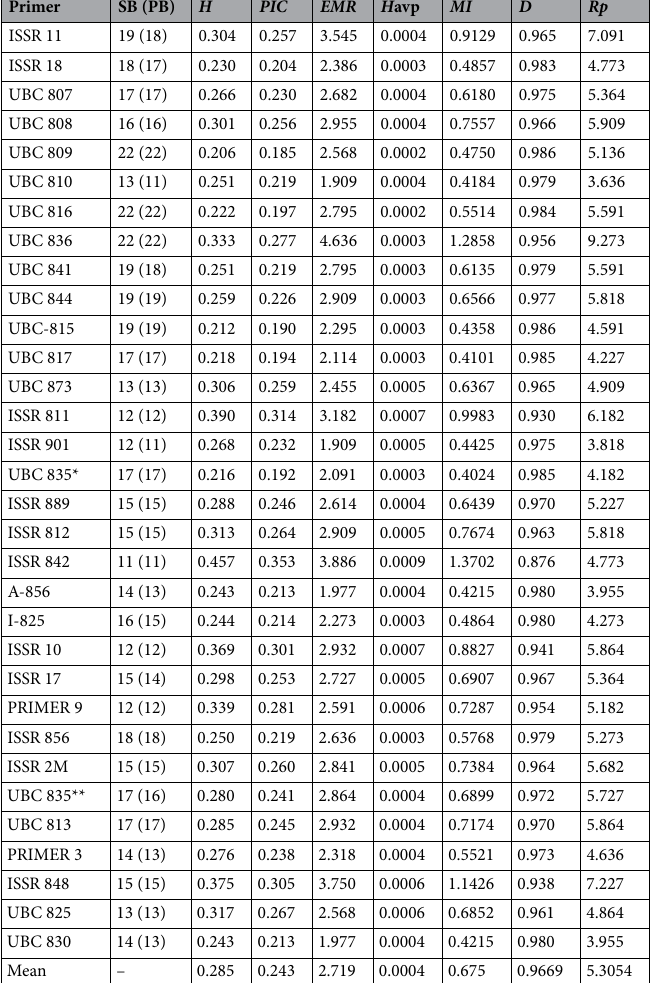
Table 3. Efficacy of primer polymorphism calculated with iMEC of Bambara groundnut genotypes. SB scored bands, PB polymorphic bands, D discriminating power, Emr effective multiplex ratio, H expected heterozygosity, Havp mean heterozygosity, MI marker index, PIC polymorphism information content, Rp resolving power. * and **Both (UBC 835) name is same as per the source of the collection, but the sequences are not same and collected from two different